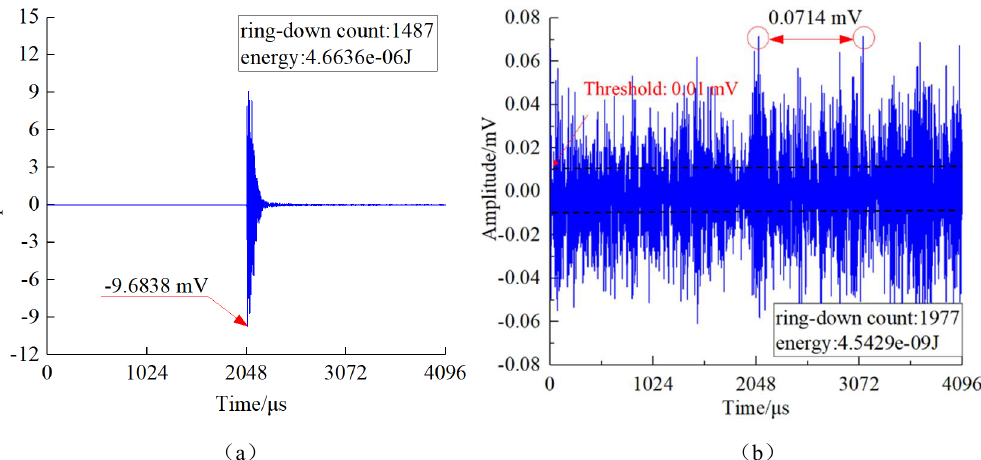
Figure 10. Two special waveforms in HF. ( a ) example waveform with low count and high amplitude: ( b ) example waveform with high count and low